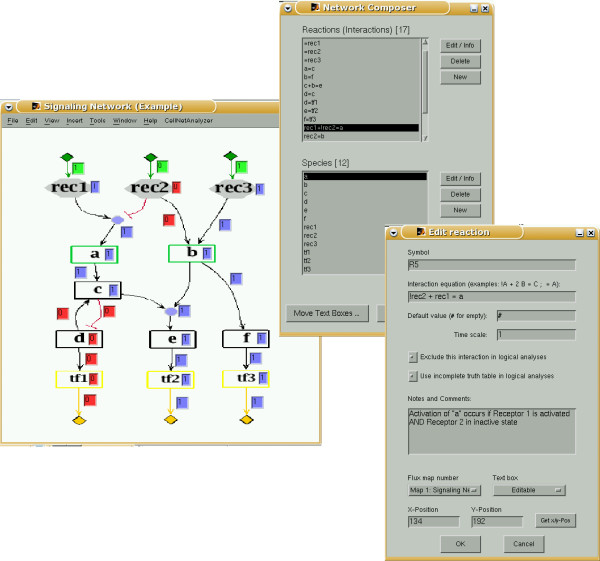
Example of an interactive network map of a simple signalling network. (Map and model were created with ProMoT [11] and exported to CellNetAnalyzer.) Note that the red edges represent inhibition (NOT operation) and blue circles indicate logical ANDs (compare also with Table 1). In the presented scenario, receptors rec1 and rec3 are activated by external signals, whereas receptor rec2 is not. The text boxes along the (hyper)arcs display signal flows (green boxes: fixed signal prior computation; blue boxes: signal flow activating a species (signal flow is one); red boxes: no activating signal is flowing along this connection). The text boxes attached to the species represent the states of the nodes in the resulting logical steady state. Network composer and the mask for editing reactions/interactions are also shown.